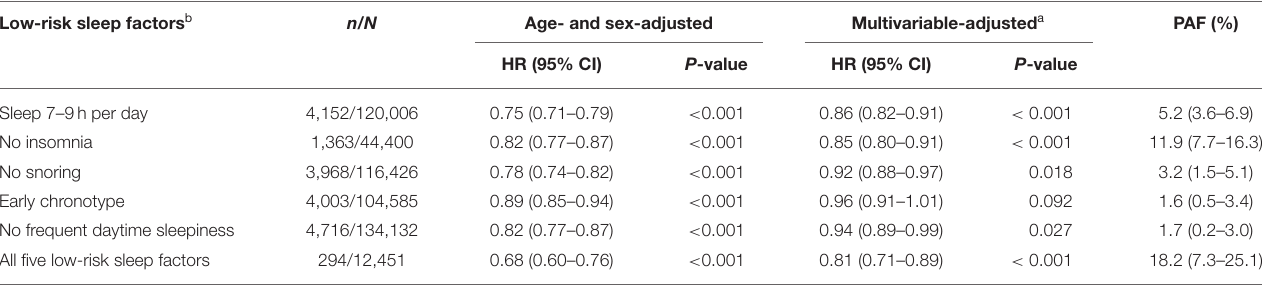
TABLE 2 | Risk of incident hypertension according to low-risk sleep factors. Low-risk sleep factors b